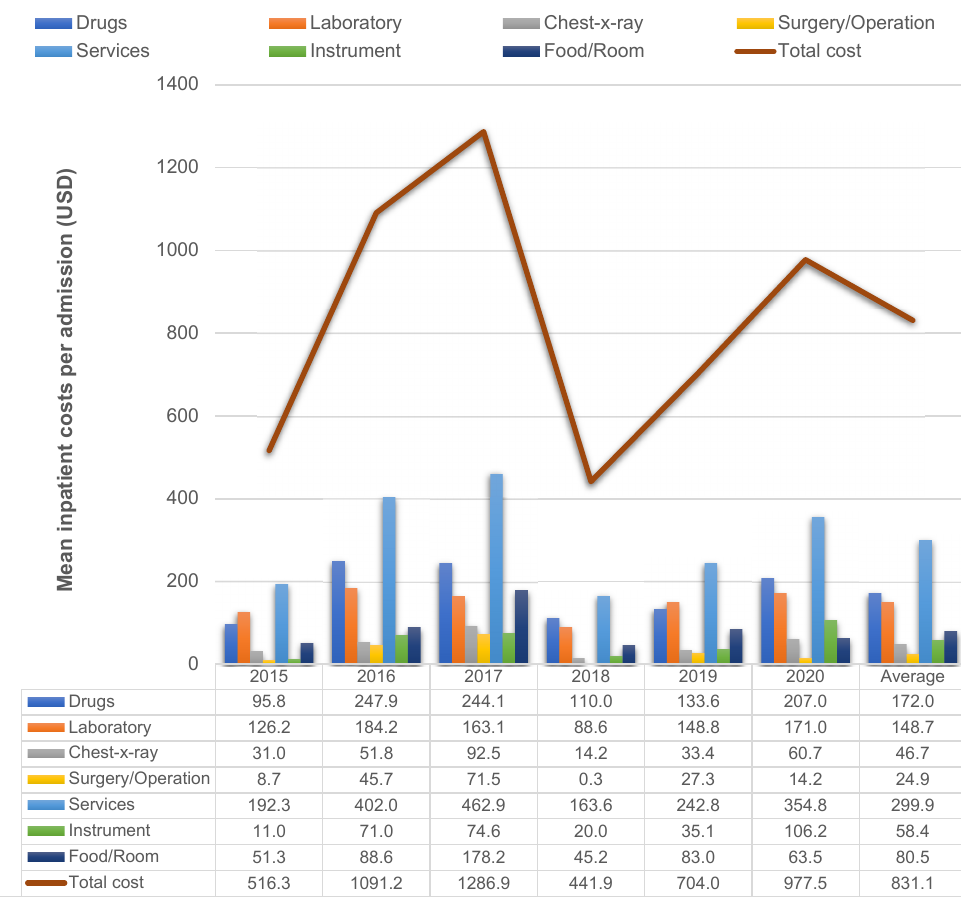
Figure 2. Mean outpatient costs per visit over a 6-year period.